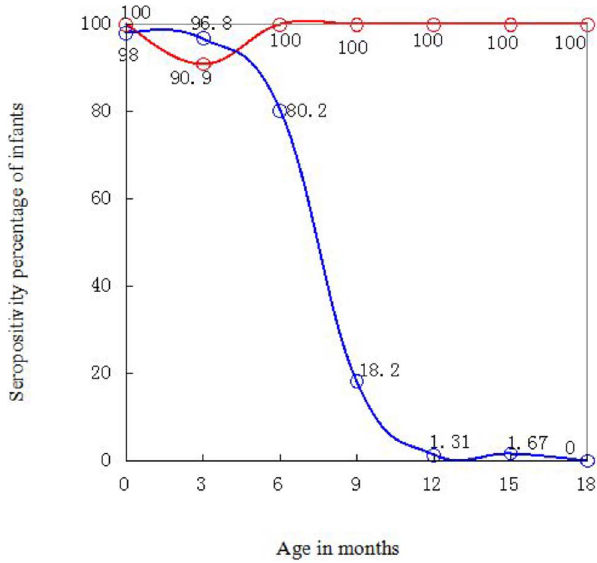
Figure 3. Mean anti-HIV S/CO values of infants. Red and blue lines indicate infected and uninfected infants, respectively. Calculations were based on 943 DBSs from 256 uninfected infants and 82 DBSs from 24 infected infants. At each month of age, sample sizes of infected babies were all $ 11 except at 9 months of age with 6 samples; sample sizes of uninfected babies were all $ 93.